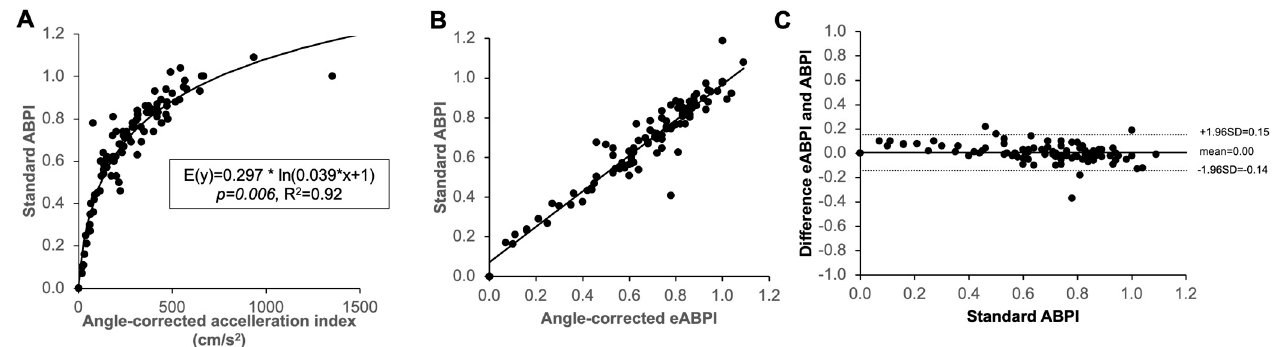
Figure 3. ( A ) Non-linear regression analysis to derive best-fit curve for eABPI using AccI from angle-corrected duplex Doppler, comparing with standard ABPI in limbs aiming to exclude media sclerosis (ABPI ≤ 1.1). ( B ) Significant correlation between eABPI and standard ABPI (r = 0.96, p < 0.001). ( C ) Bland Altman plot demonstrating an average deviation of 0.00 when comparing eABPI with standard ABPI with a standard deviation of differences of 0.08 ( n = 100).